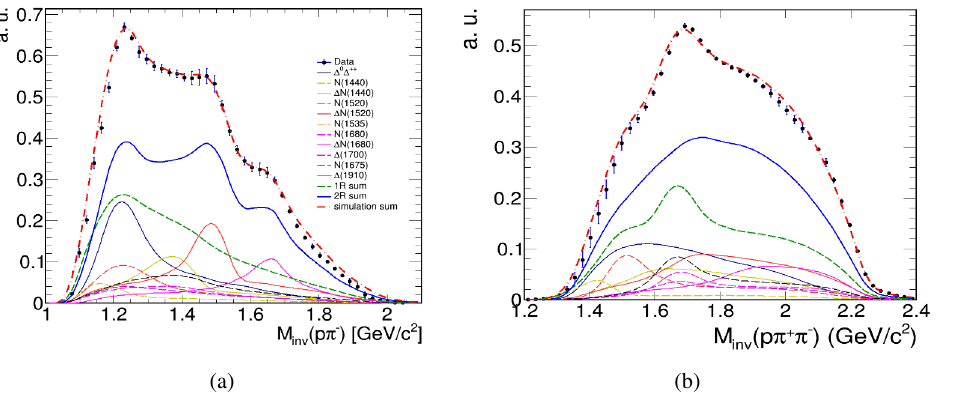
Figure 1: p π − (a) and p π + π − (b) invariant mass distribution, compared to simulations: Data (black dots), sum of all simulation contributions (dashed red) double resonance sum (blue), one resonance sum (dashed green).